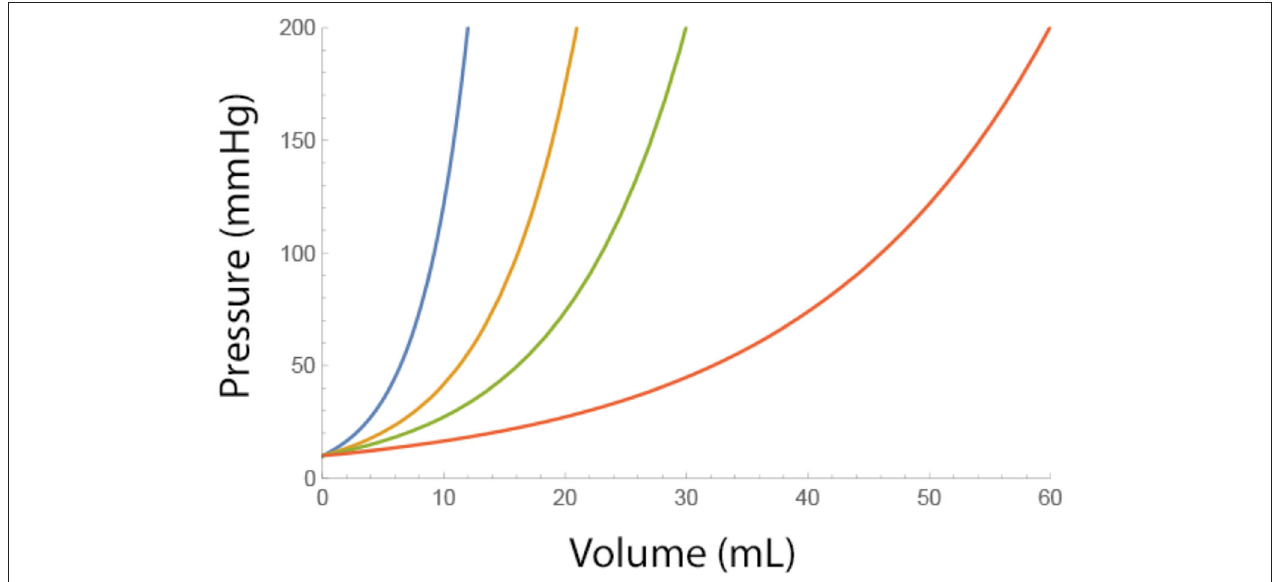
FIGURE 1 | Effect of a single bolus fluid injection on the epidural pressure for different adverse conditions (i.e., low values of A). Blue A 10, and Red A 20ml. Pbaseline 10 = =